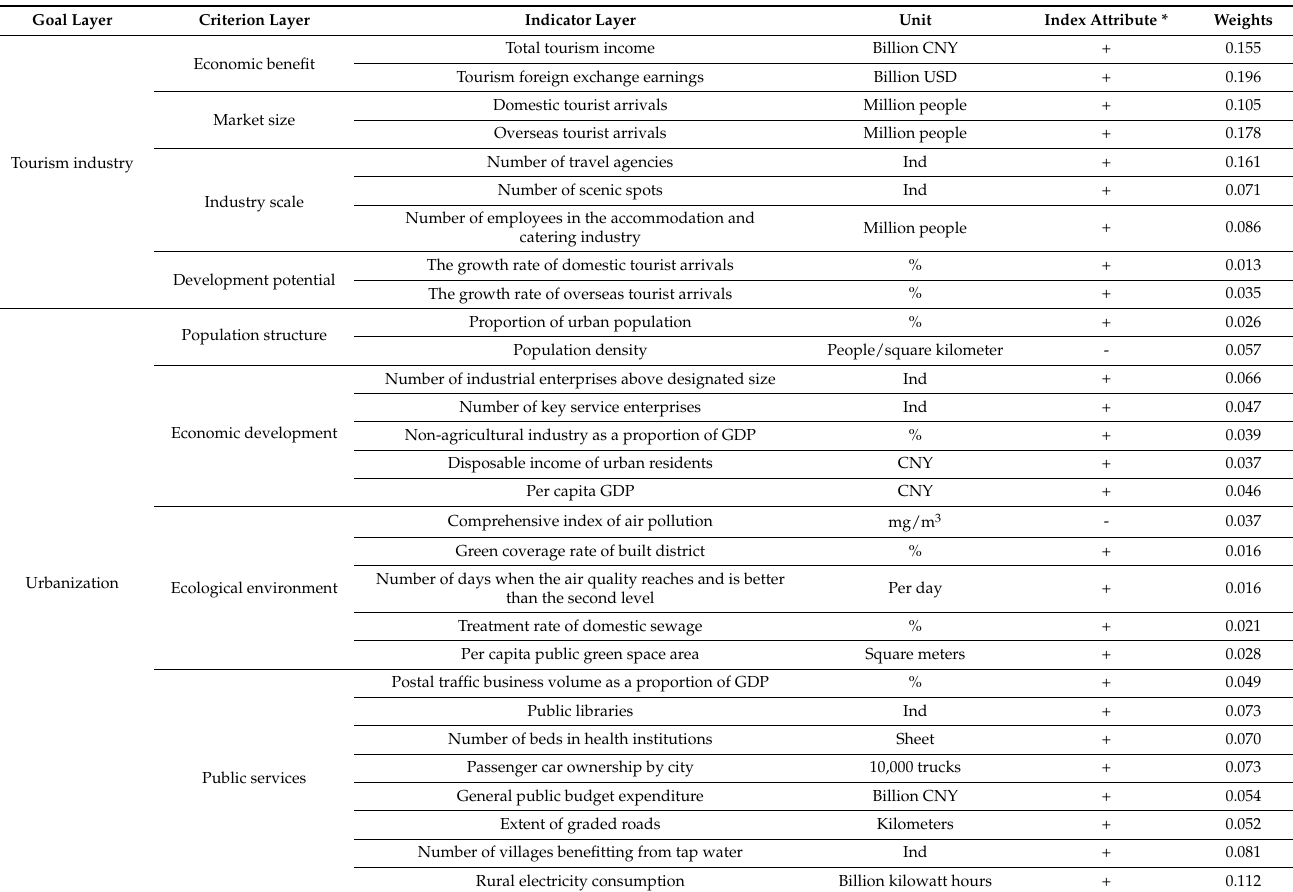
Table 1. The comprehensive evaluation index system and weight of the tourism industry and urbanization of the mountainous border areas of Western